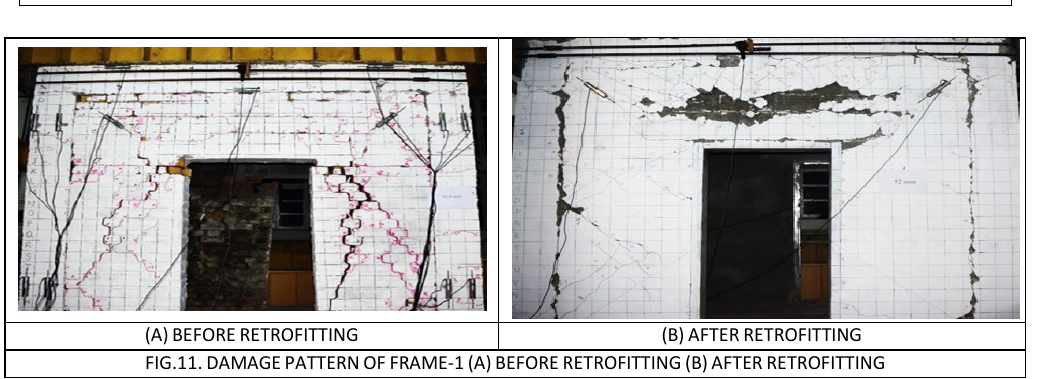
FIG. 10. INSTRUMENTATION OF RETROFITTED FRAME-2